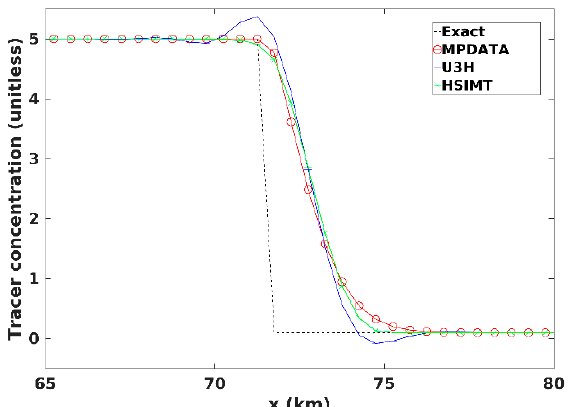
Figure 2. Test Case 2: Horizontal tracer patch propagation; Comparison of tracer advection schemes